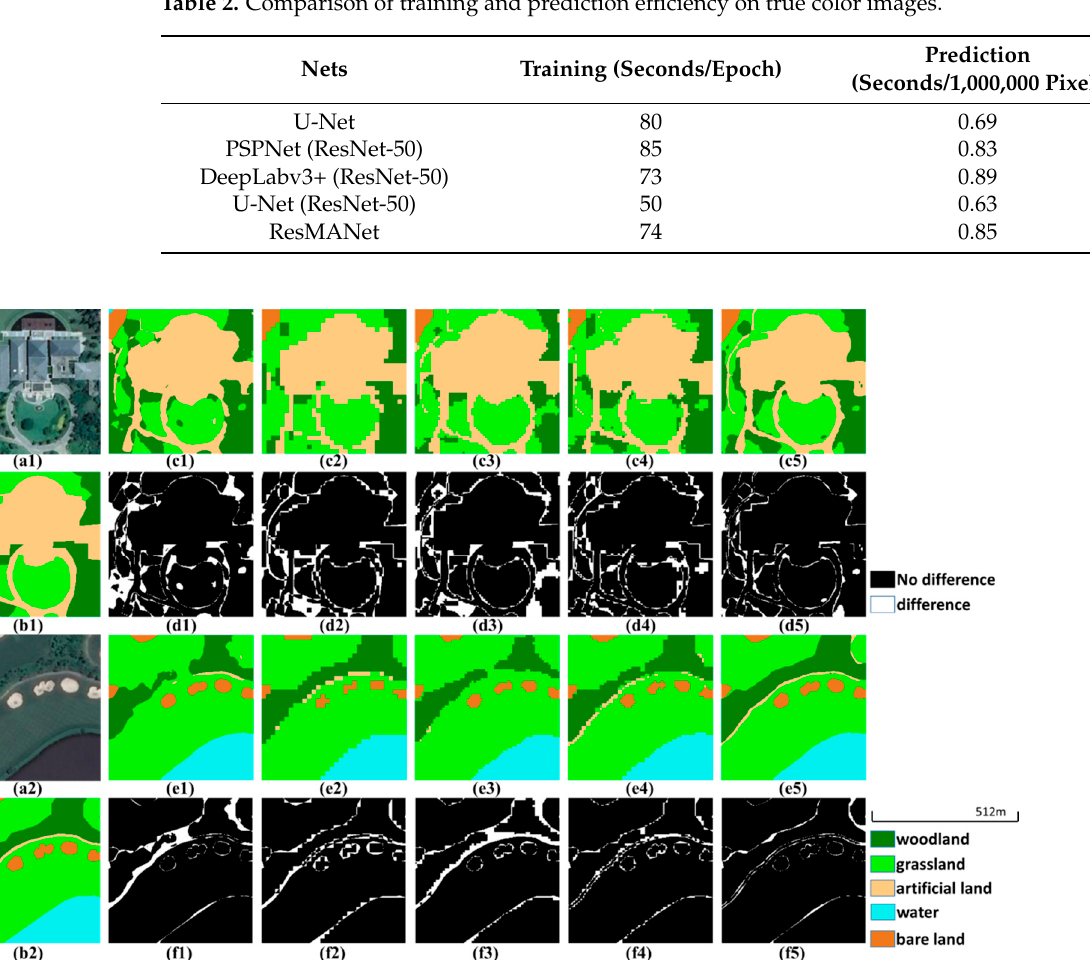
Table 2. Comparison of training and prediction efficiency on true color images.